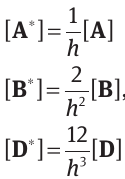
Table 2: T700/epoxy C-ply™ NCF’s ply [28, 31] and sub-laminate (homogenized laminate) properties (V